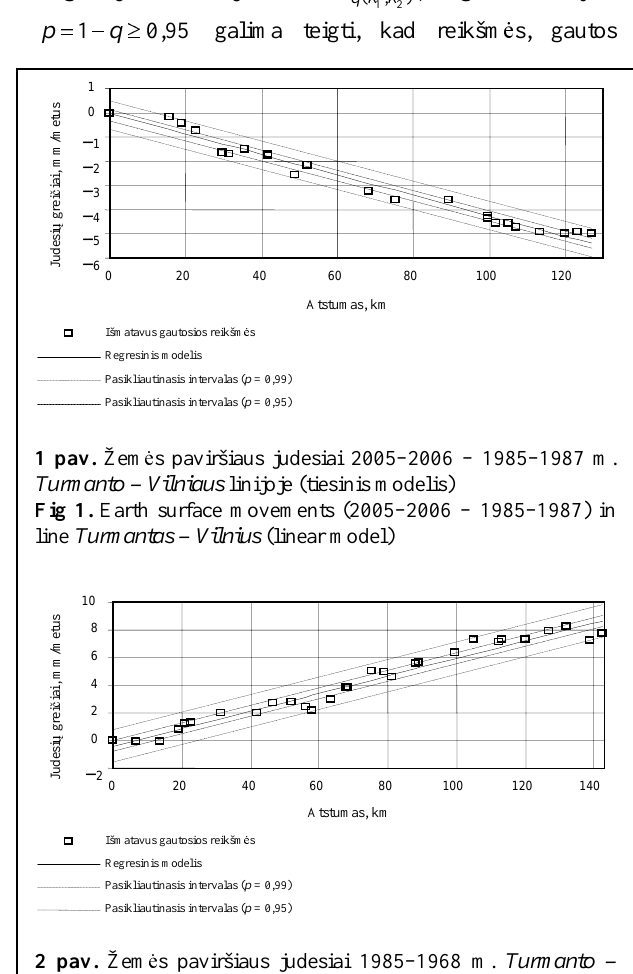
Fig 2. Earth surface movements (1985–1968) in line Turmantas